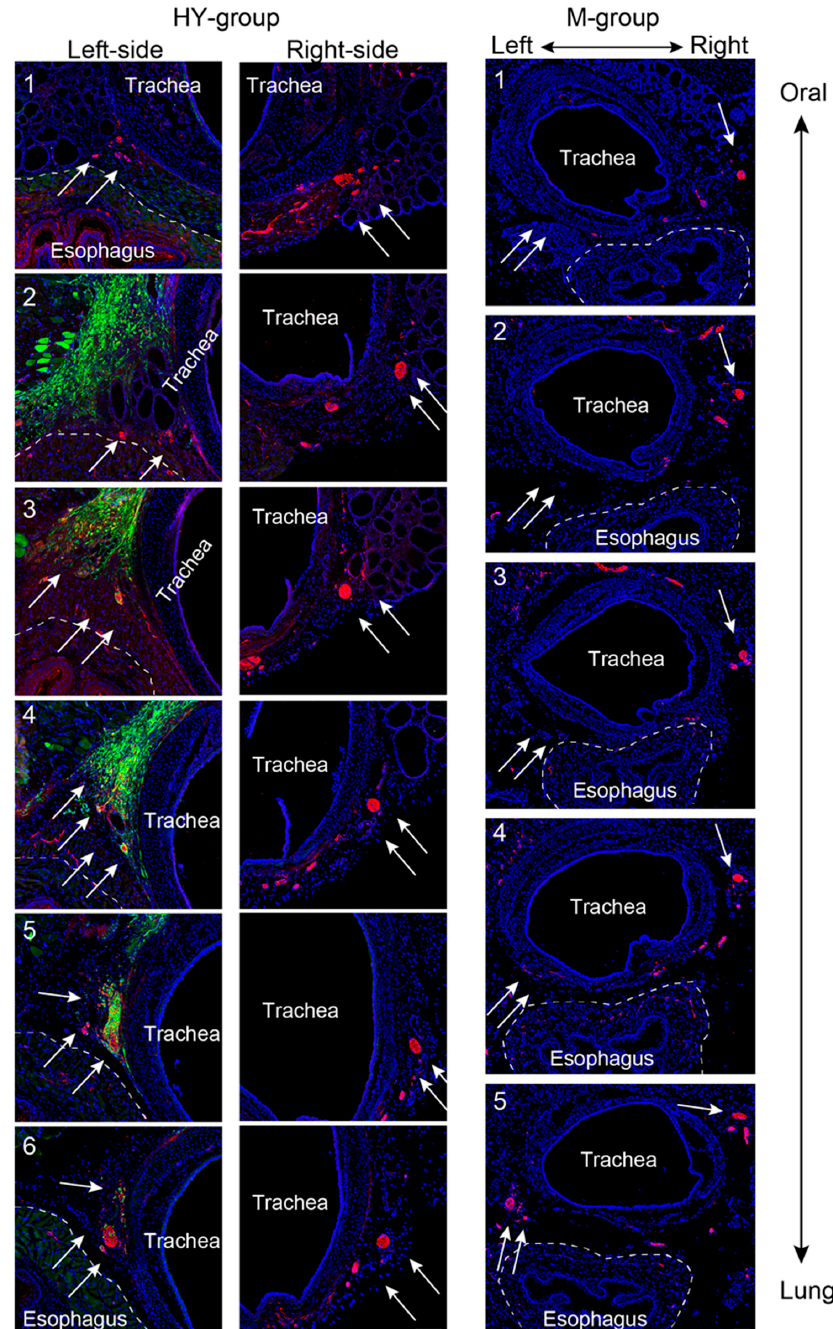
Figure 3. Serial cross-sectional examination of the RLN regeneration in the HY- and M-group. Numbers in each photograph are in serial order from the proximal (oral) to distal (lung) side. Similarly, arrows indicate the expected situation of the RLN both on the right and left side. All sections were stained with anti-N200 as axon staining (red reactions). Axons can be seen through the serial sections of the HY-group both in the contralateral right- and operated left-side. In addition, Sections 3–6 on the left-side of the HY group show encircling of GFP + cells/tissues of N200 + axons. However, axons are undetected on the left-side of the M-group, showing the incomplete regeneration of the RLN. Dotted lines show the outermost layer of the esophagus. Blue staining is nuclear staining with DAPI. Bars = 100 μ m. The formation with very few axons in the RLN defected portion of the PGA group is shown in Figure S1.